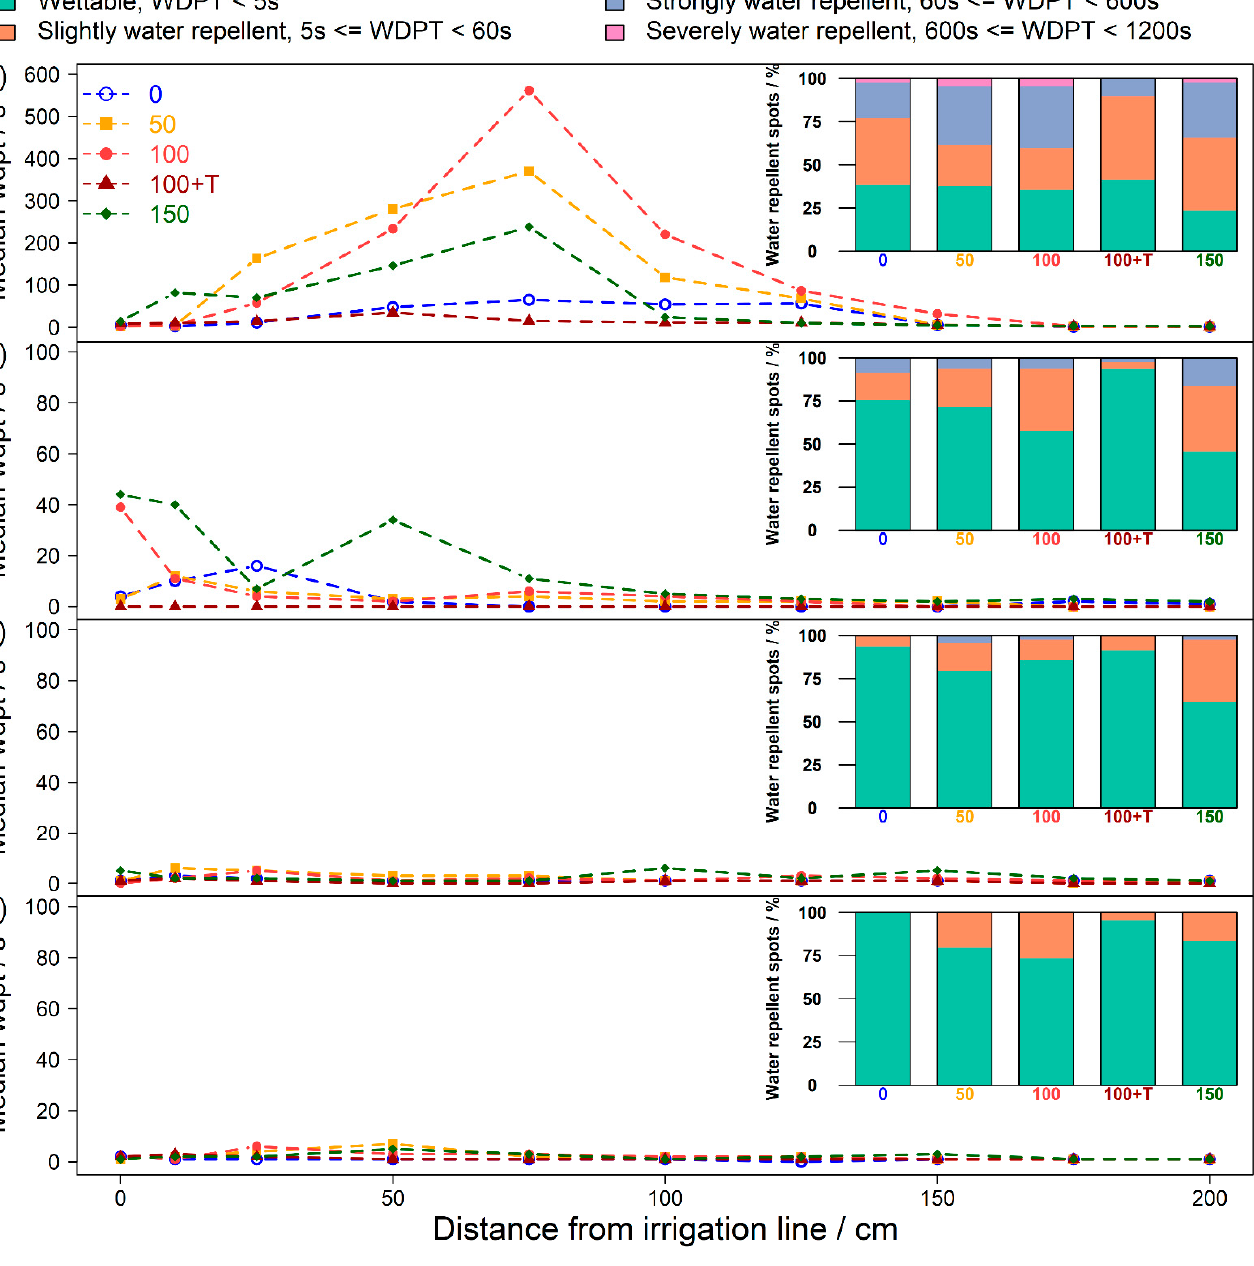
Figure 1. Median values of water drop penetration time (WDPT) measured in distance steps of 20 cm from the drip irrigation line. ( a ) 2013; ( b ) 2014; ( c ) 2015; ( d ) 2016. Subplot (stacked bars) shows the frequency distributions of four hydrophobicity categories ranging from wettable to strongly water repellent. OMW application rates are 0 (control), 50, 100, and 150 m 3 ha − 1 y − 1 and 100 m 3 ha − 1 y − 1 followed by shallow tillage (100 + T).